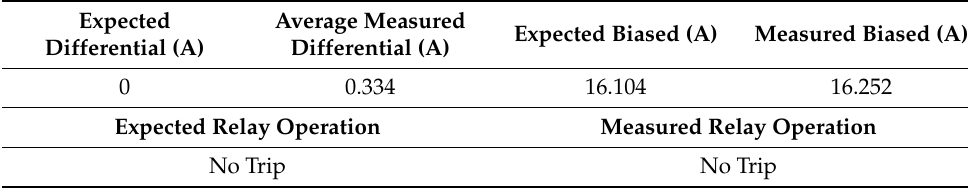
Table 4. Results comparison for the stable condition.